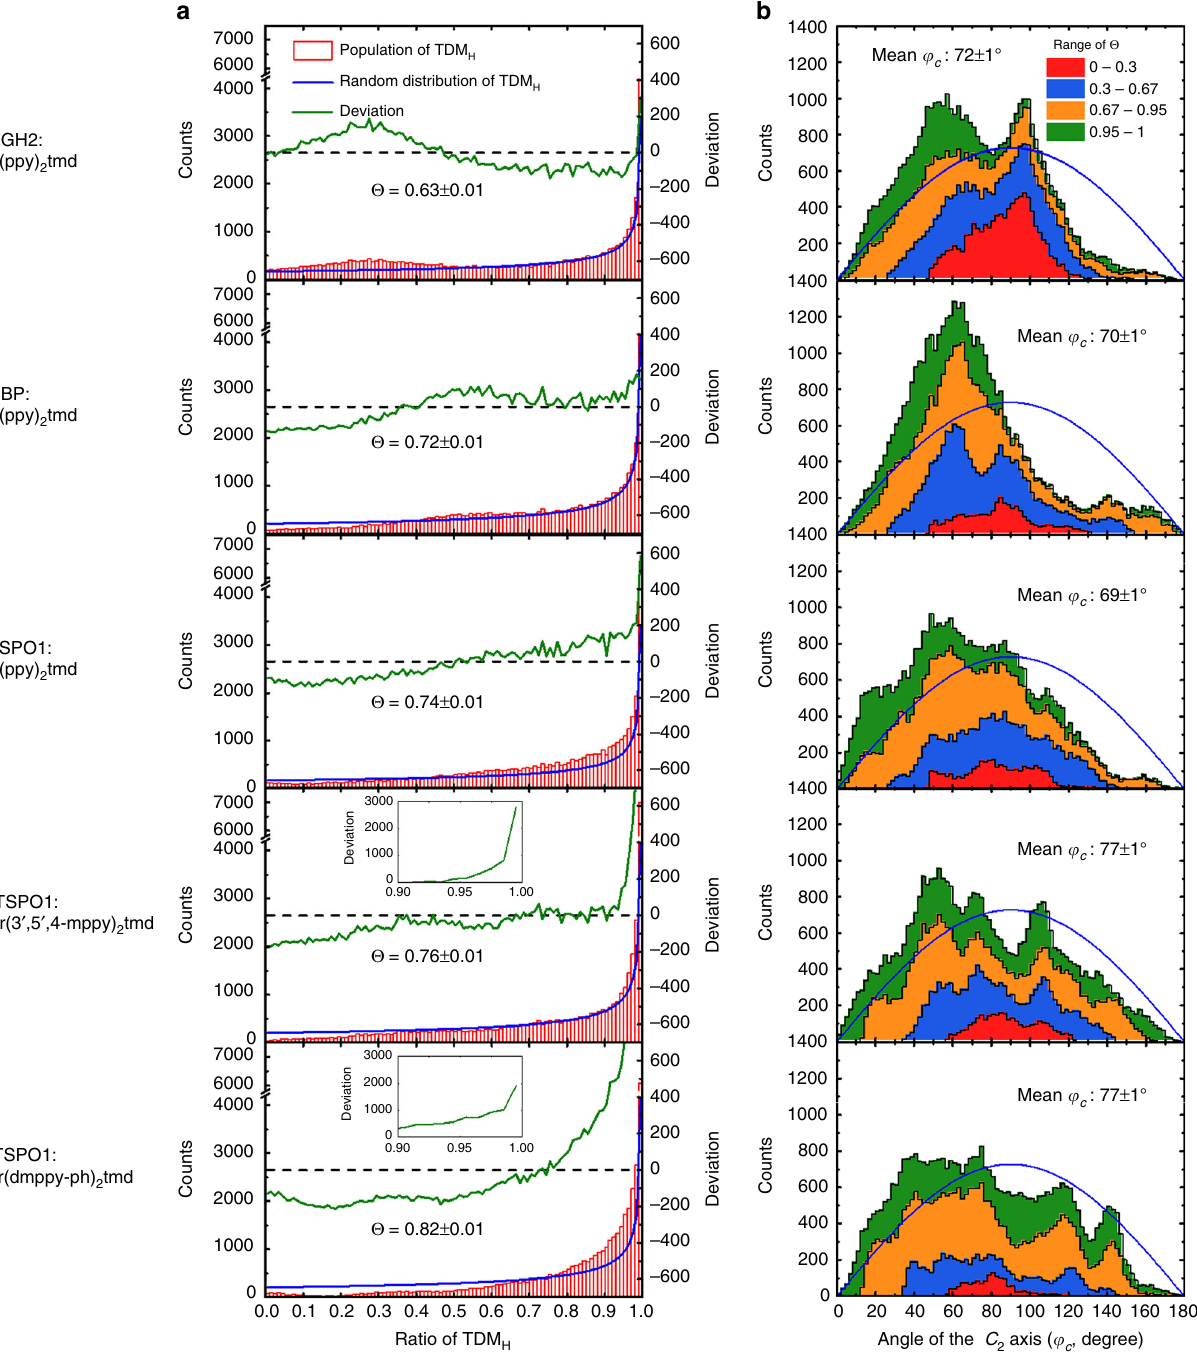
Fig. 3 Histograms in fi gure host – dopant combinations from deposition simulation. Each histogram includes 41,700 data in total from the con fi gurations during 50 cases of the deposition in steps of 6 ps in the time regions of 1 – 6 ns. Data in the time region < 1 ns were not used in the statistical analysis to exclude the steps of adsorption and the initial equilibration. a Histograms of the EDO with simulated Θ values. Red bars indicate the population of the phosphor con fi gurations having TDM H values in steps of 0.01. Blue lines are theoretical lines of TDM H from an arbitrary vector of which detailed derivation is given in Methods section. Green lines represent deviations of the population compared to the distribution of TDM H of an arbitrary vector. ( Inset : enlarged deviation in the region of 0.8 ≤ TDM H ≤ 1) b Stacked histogram of the angle of the C 2 axis of phosphors and mean angles. Populations of the vector are plotted in steps of 2°. Distribution of the angle in different ranges of TDM H is distinguished by different